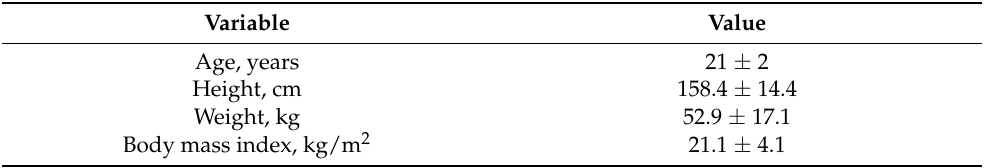
Table 3. Baseline characteristics of participants ( n = 12).